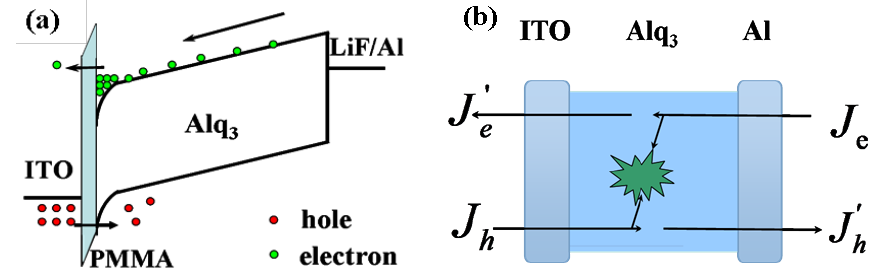
Figure 3. ( a ) The schematic diagram of influence of stored charges on carrier tunneling ( b ) the mechanism of current flowed in OLEDs.